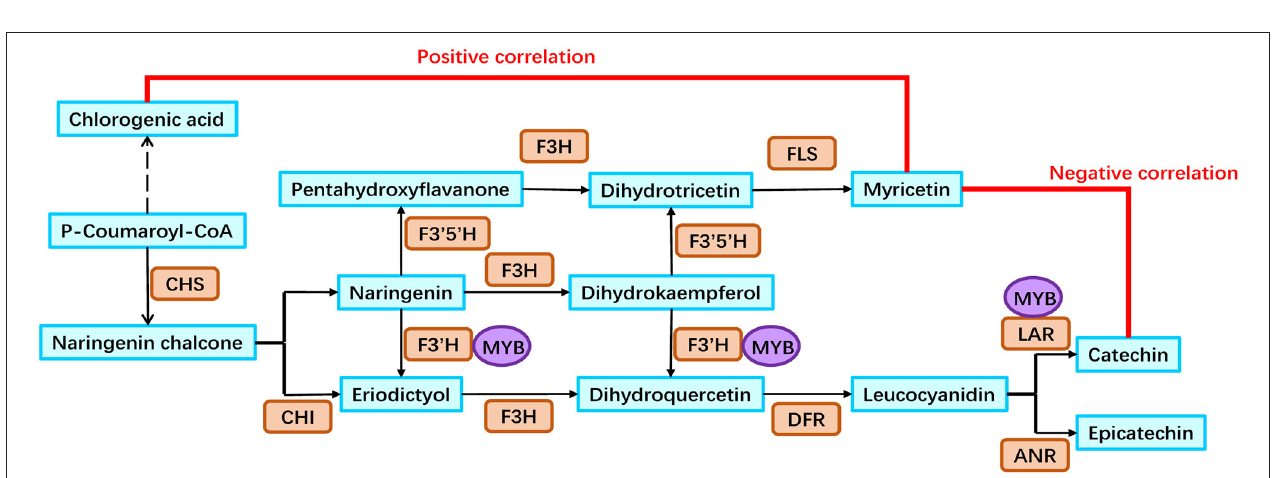
FIGURE 6 | Flavonoid biosynthesis pathway in the rhizomes of golden buckwheat. Cyan boxes represent the metabolites in the flavonoid biosynthesis pathway. Orange rounded boxes represent enzymes that catalyze the reactions in the flavonoid biosynthesis pathway. Purple circles represent the FcMYB1 protein that could bind to the promoters of candidate genes. Gene names of 11 enzymes are listed as follows: FcCHS2 , FcCHS3 , FcCHI1 , FcF3H1 , FcF3 ′ H1 , FcF3 ′ 5 ′ H1 , FcF3 ′ 5 ′ H2 , FcDFR1 , FcFLS1 , FcLAR1 , and FcLAR2 .